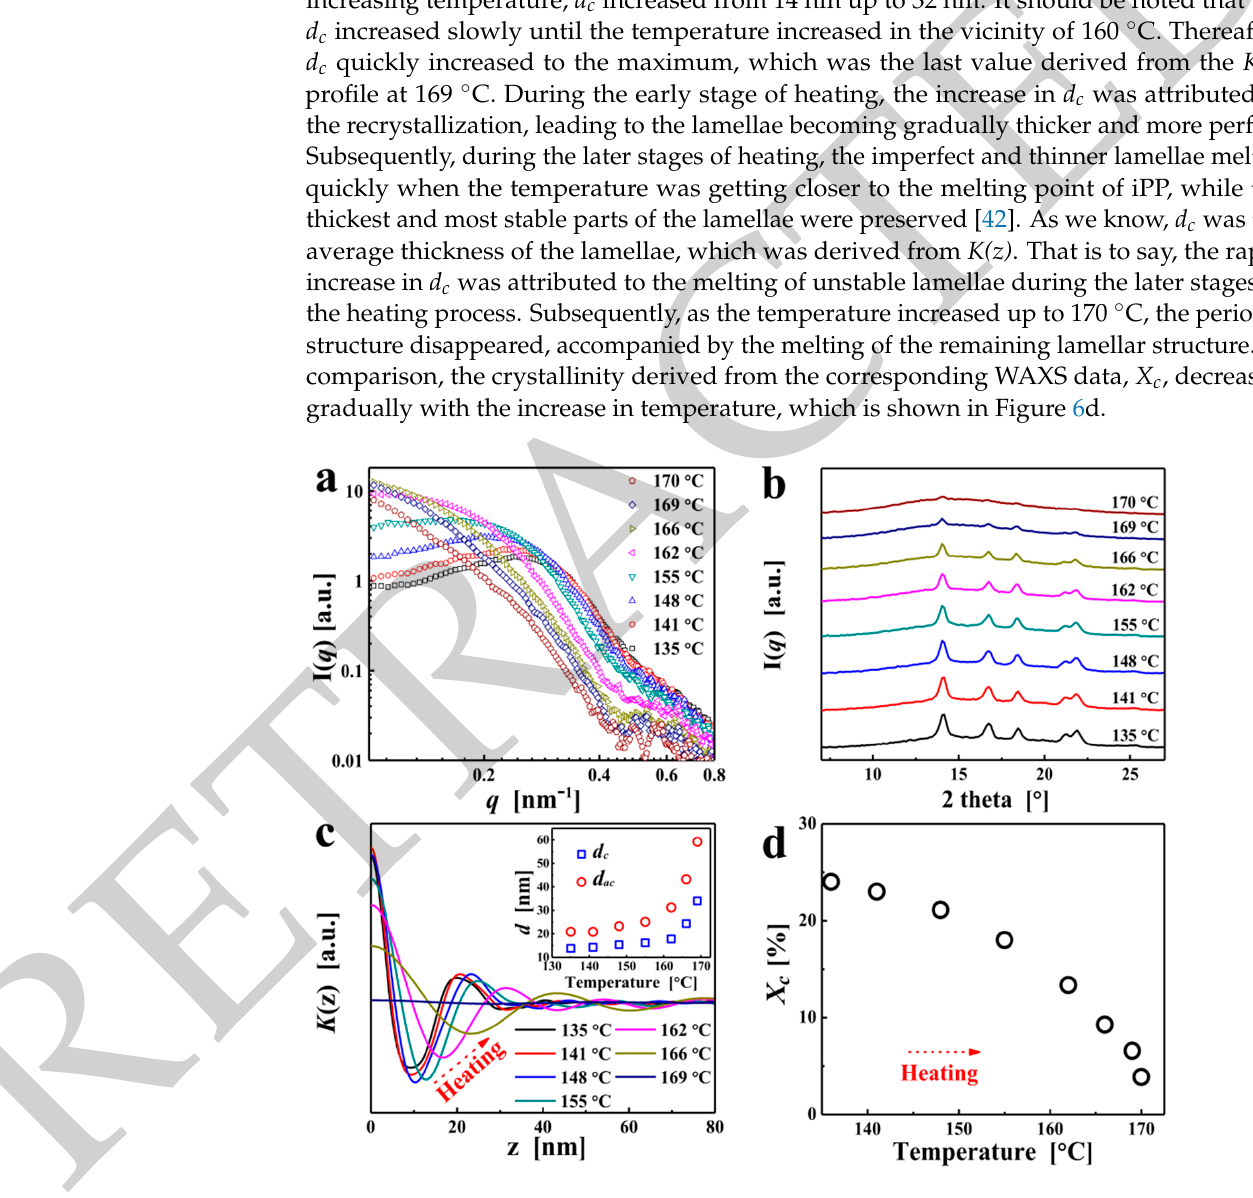
Figure 6. The structural evolution of the iPP sample during the heating process. The sample was prepared, with a thermal history as shown in Figure 1. ( a ) The selected SAXS profiles in log-log coordinate and ( b ) the corresponding WAXS profiles that were obtained during the heating process; ( c ) the evolution of one-dimensional electron density correlation function, K(z) . The evolution of long-period ( d ac ) and lamellae thickness ( d c ) were shown as inset; ( d ) the corresponding evolution of crystallinity derived from the WAXS